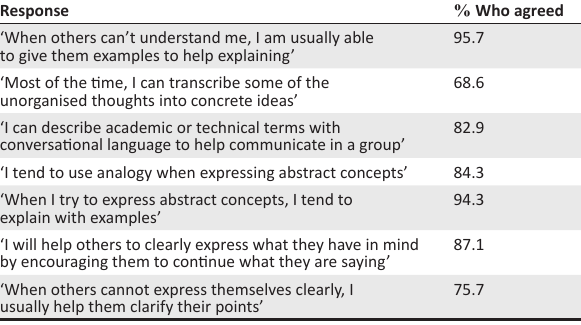
TABLE 4: Respondents’ use of externalisation.